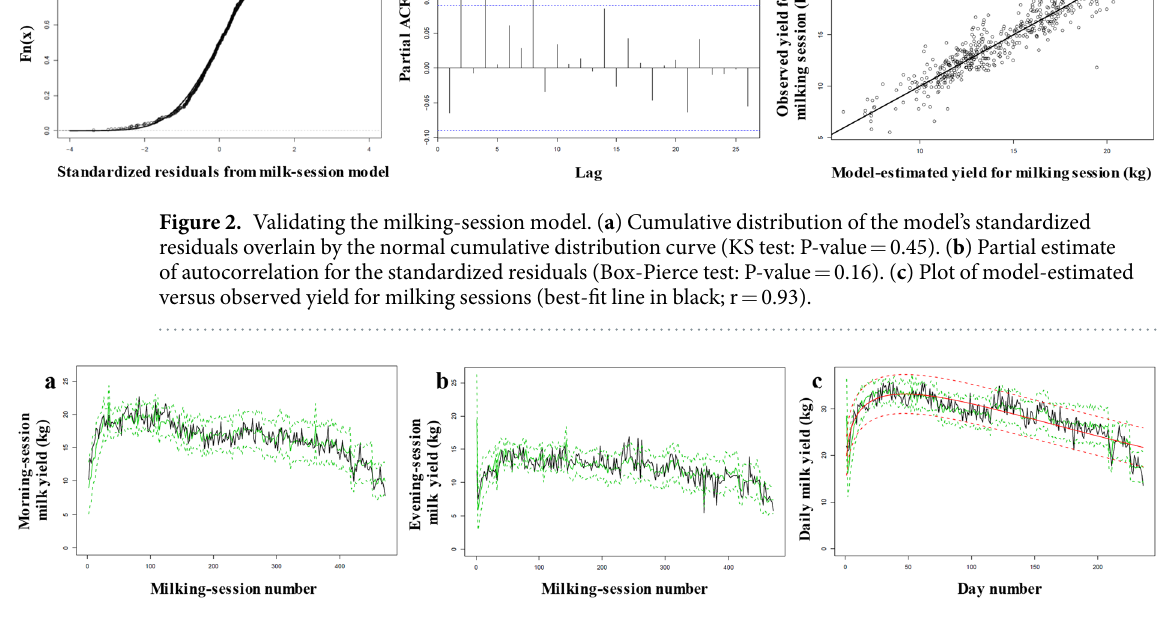
Figure 3. Observed versus estimated milk yield. Values for ( a ) morning milking sessions, ( b ) evening milking sessions, and ( c) , full days. Observed yield is represented by a solid black line. Model-estimated yield and the 95% CI are represented by green lines (solid and dashed, respectively). The estimated yield from Wood’s model and the 95% CI are represented by red lines (solid and dashed, respectively).